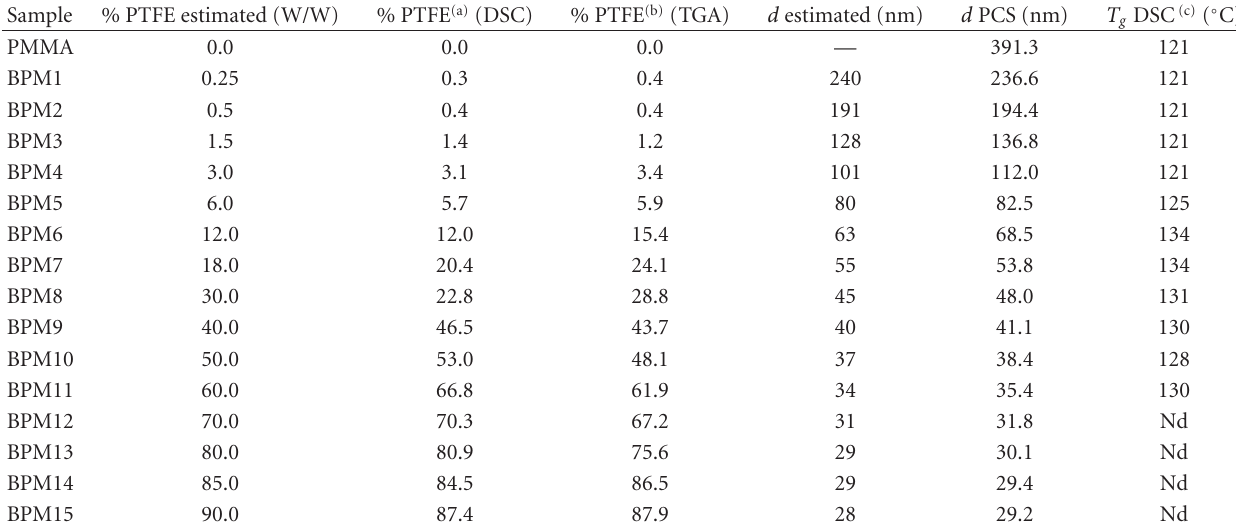
Table 2: Size and composition data of the various samples.